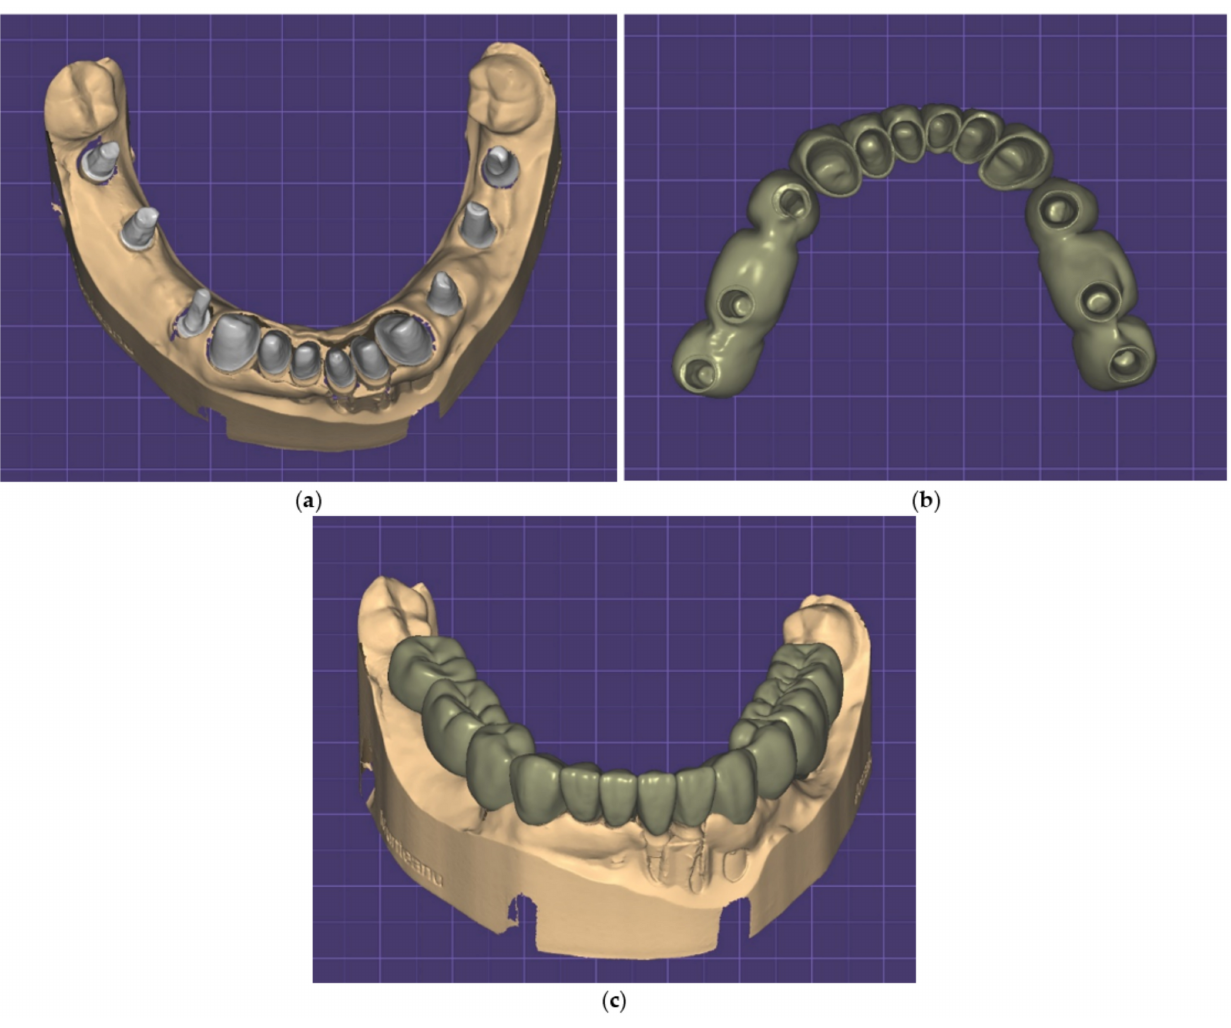
Figure 7. ( a ) Aspect of the scanned working cast, with stock milled abutments and customized CAD-CAM abutments; Bredent standard abutments 44, 46, 47; custom CAD-CAM abutments with Bredent connection 34, 36, 37; ( b , c ) the design of the front dental prosthetic restoration and the two lateral implant-prosthetic